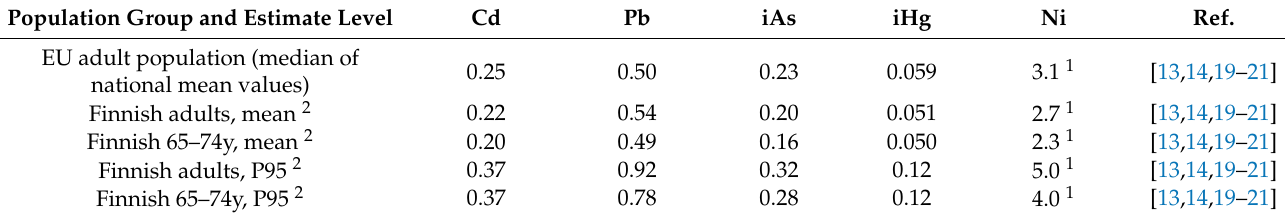
Finnish adults, P95 2 0.37 1 Value is average of reported lower bound and upper bound estimates. 2 Based on FinDiet 2007 consumption